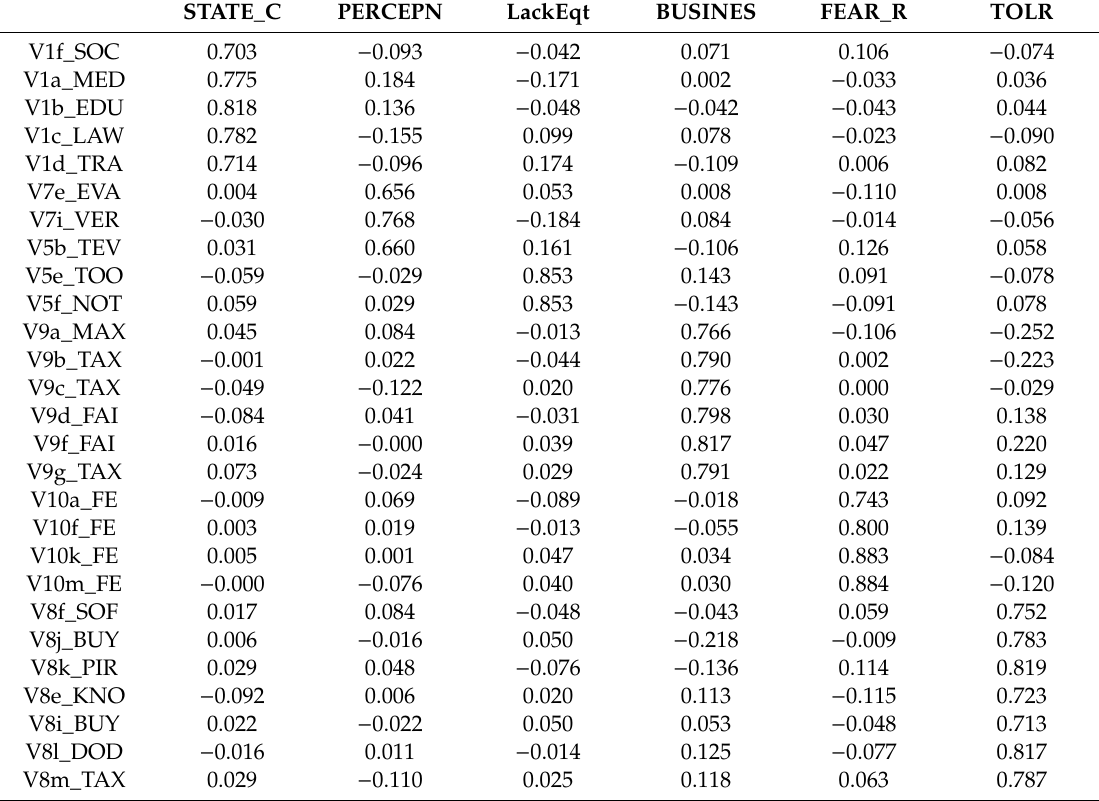
Table 3. Loadings and cross